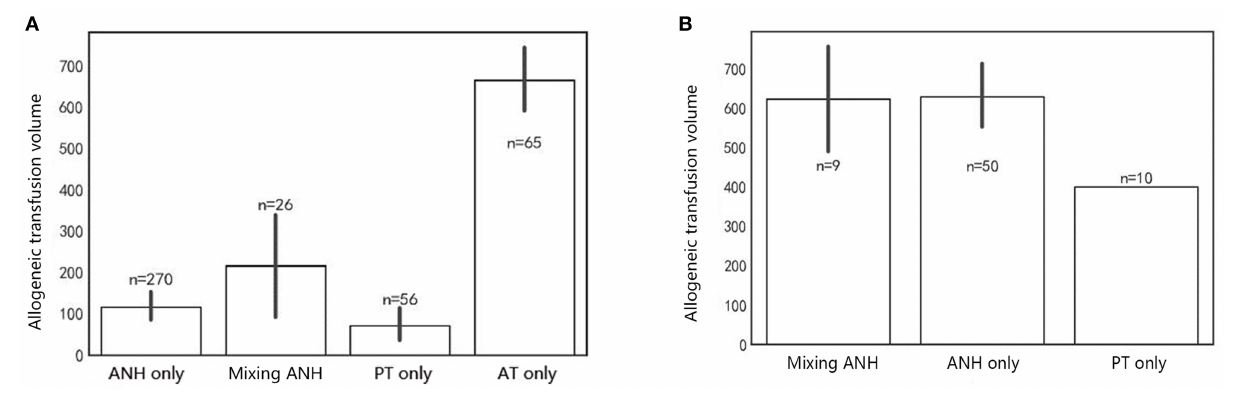
Under the circumstance of mixed transfusion, the combined allogeneic transfusion volume was statistically significantly different among the three groups ( Figure 2B ) ( p = 0.017).